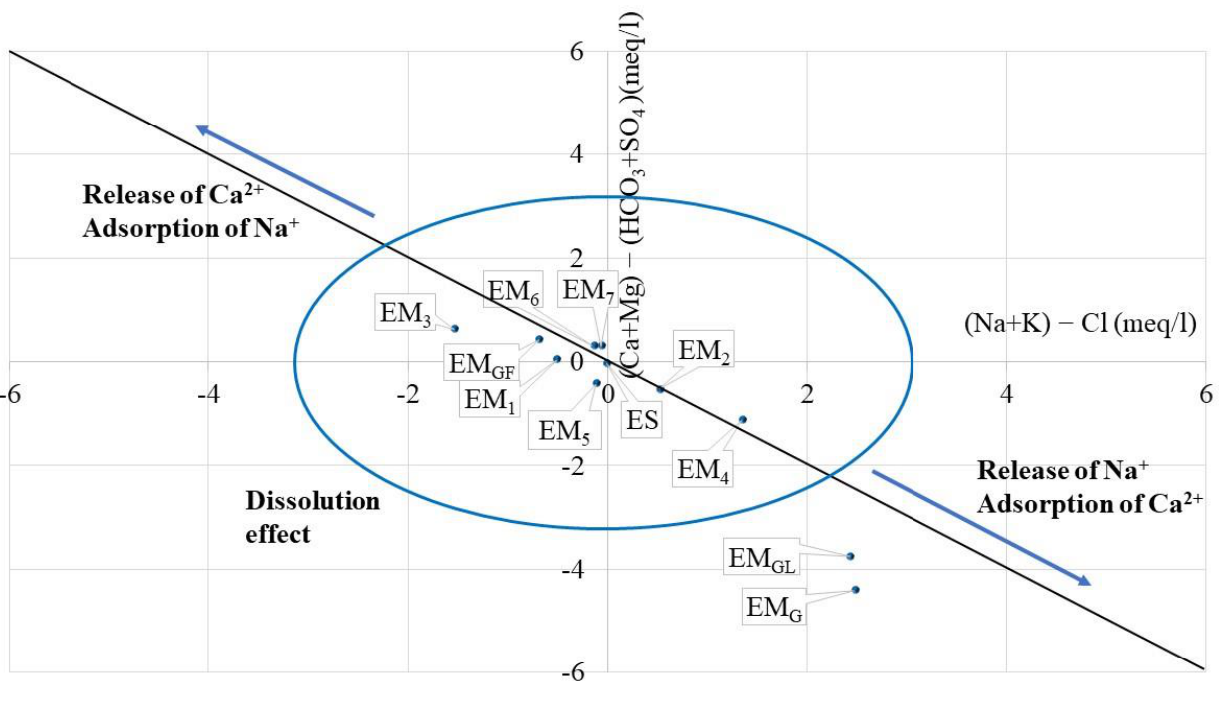
Figure 5. Scatter plot of ((Ca+Mg) − (HCO 3 +SO 4 )) versus ((Na+K) − Cl